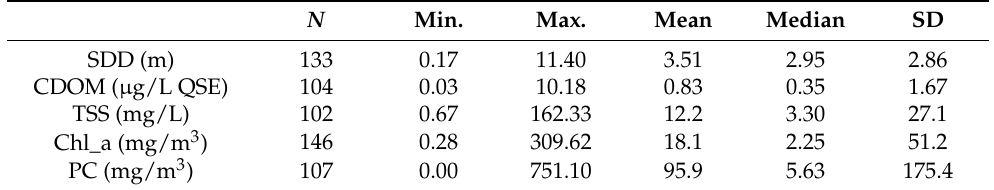
Table 3. Descriptive statistics of the measured water parameters: Secchi disc depth (SDD), colored dissolved organic matter (CDOM), total suspended sediment (TSS), chlorophyll a (Chl_a),